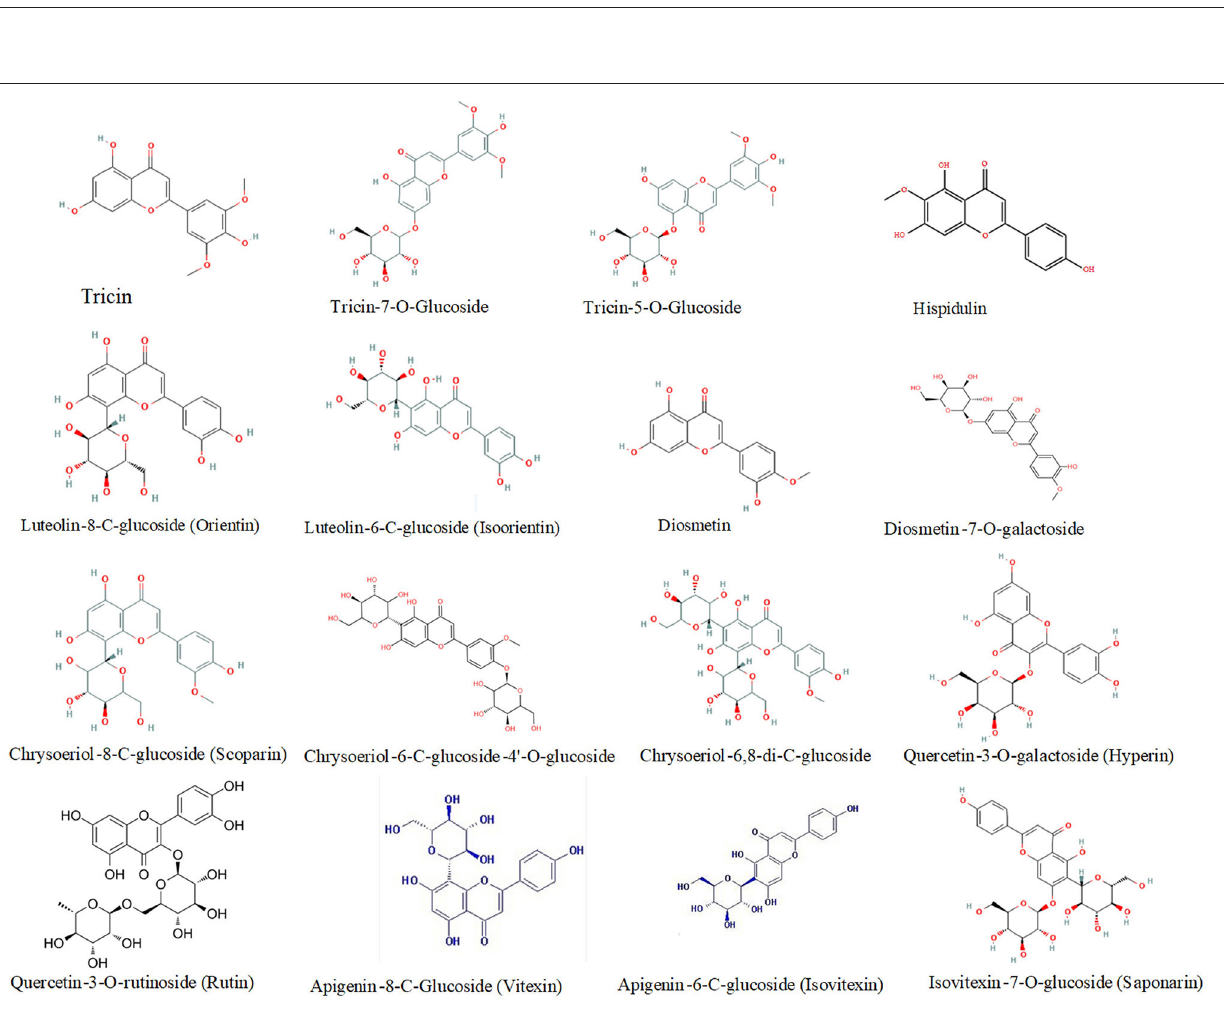
Frontiers in Nutrition |